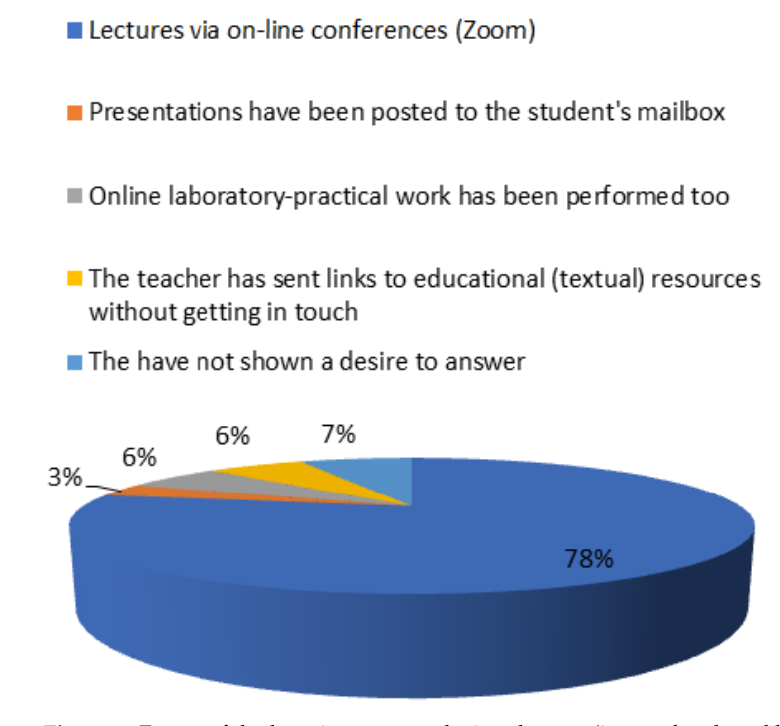
Figure 5. Forms of the learning process during the war (image developed by the authors).